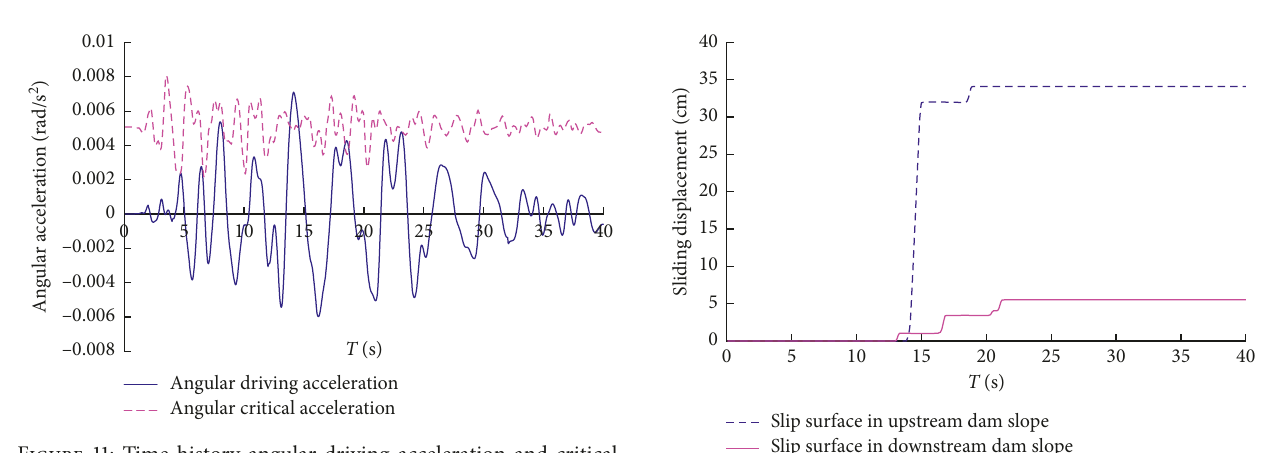
Figure 11: Time history angular driving acceleration and critical acceleration of slip surface in upstream dam slope.